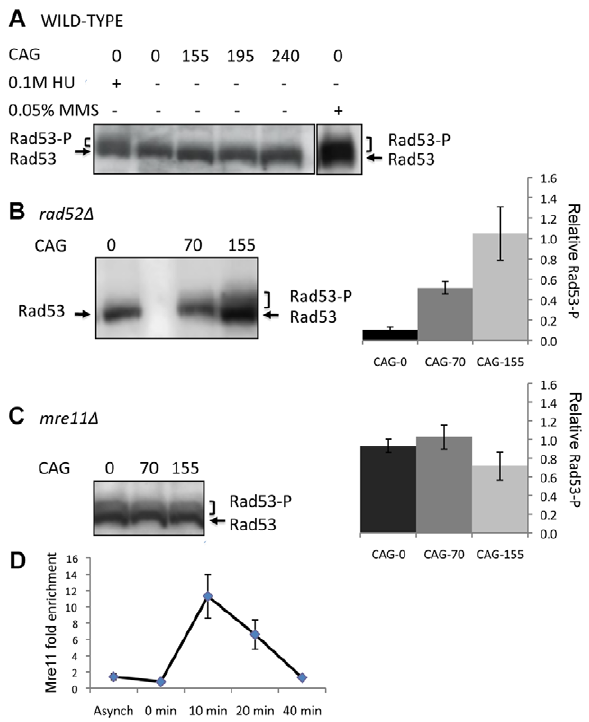
Figure 5. Rad53 phosphorylation status and Mre11 localization in strains with expanded CAG/CTG repeats. Western blots of protein extract from (A) WT (B) rad52 D , and (C) mre11 D cells probed with Rad53 antibody. Extracts treated with 0.1 M HU (A, lane 1) or 0.05% MMS (A, lane 6) are included as positive controls. Quantified equal amounts (15 ng) of total protein prepared from asynchronous cultures were loaded per lane; the positions of unphosphorylated Rad53 (93 kDa) and hyperphosphorylated Rad53 species (Rad53-P) are indicated by arrows and square brackets, respectively. Rad53 hyperpho- sphorylated species were quantified and normalized to the Rad53 intact band; average of 3 experiments with standard error of the mean (SEM) is shown for rad52 D (B, right) or mre11 D (C, right) strains. Similar ratios were obtained when Rad53-P signal was normalized to an internal loading control (data not shown). (D) Mre11-TAP is recruited to the CAG repeat-containing DNA fragment. A strain with TAP-tagged Mre11 and a CAG-155 repeat was used for ChIP. Chromatin samples were collected from cultures either unsynchronized (Asynch) or synchronized in G1 with a -factor, released into S phase, and samples collected at the indicated time points. Fold enrichment of Mre11 at the CAG repeat (y- axis) was obtained by normalizing PCR product amplification efficiency from DNA adjacent to the CAG repeat (CAG IP/WCE) to a control PCR product from the ACT1 locus (ACT1 IP/WCE). Error bars represent